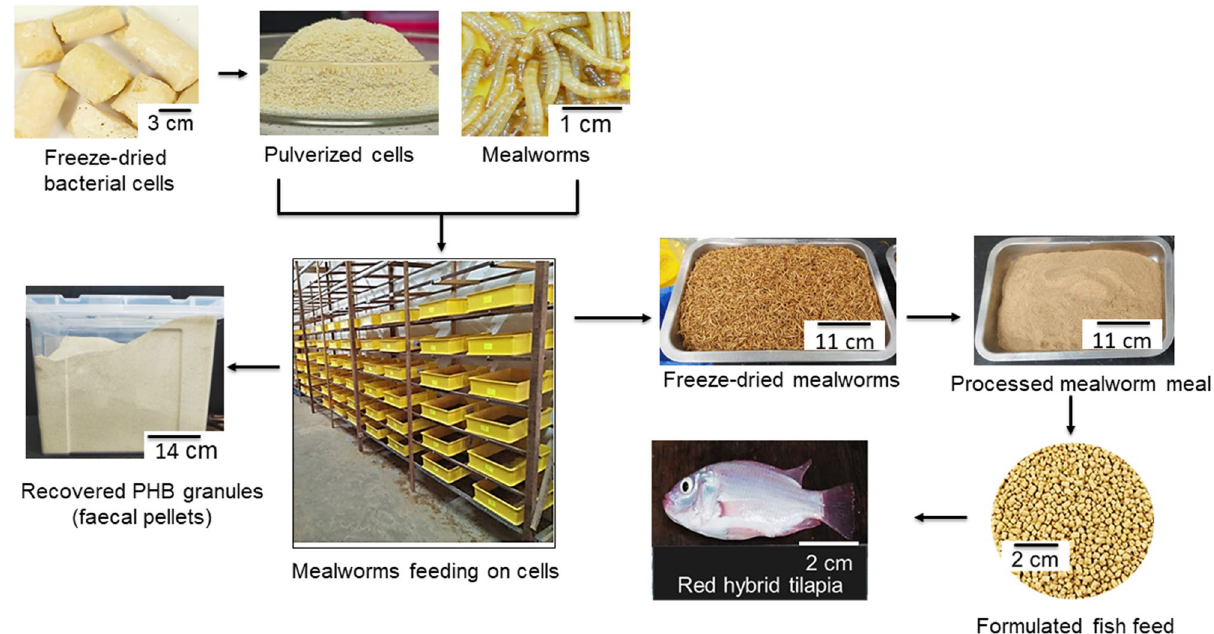
Figure 1. Process flow of the